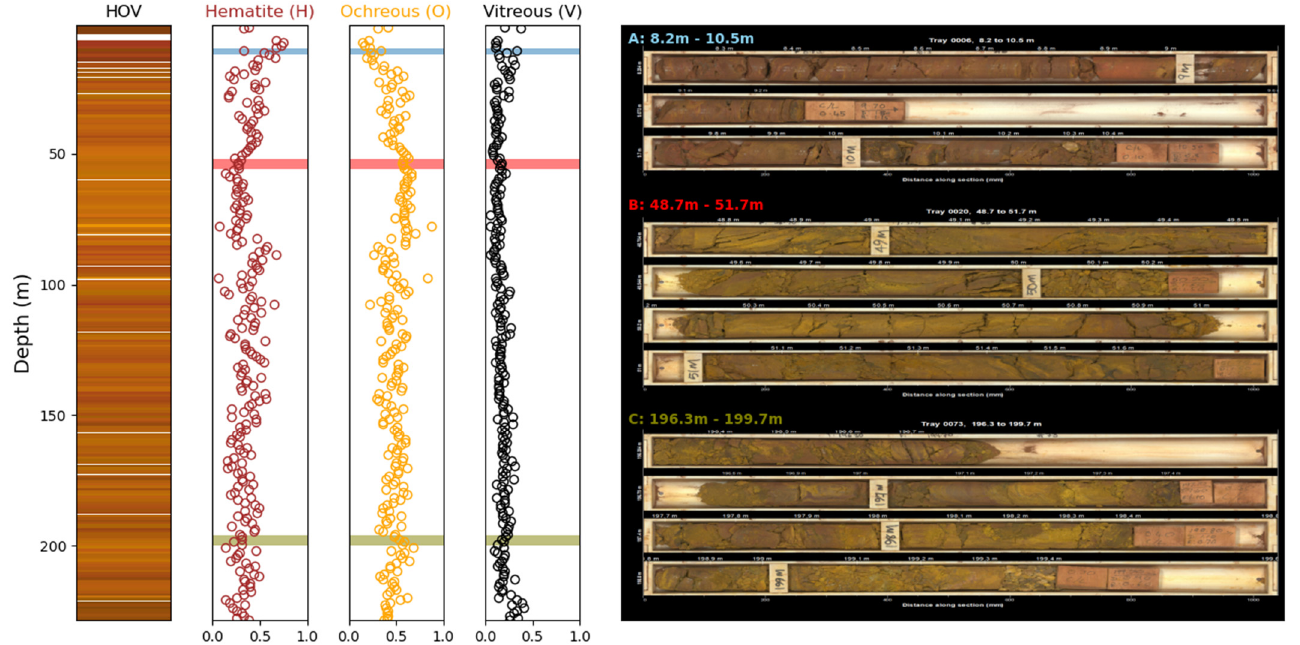
Figure 11. The first column is a false colour image of the downhole estimated mixing ratios where the RGB values are determined from the relevant endmember mixing ratio and are colored as per the mixing ratio columns (columns 2–4) of hematite (brown), ochreous goethite (orange), and vitreous goethite (black). In columns 2–4 the mixing ratios are averaged over 1 m for the drillcore and coloured by their respective endmember colours. Column 5 shows colour images of the trays at specific locations in the drill core that show the range of ochreous and vitreous goethite and hematite. The depths the core trays span are shown in colored text above each tray with their locations corresponding to the coloured horizontal bar in columns 2–4.